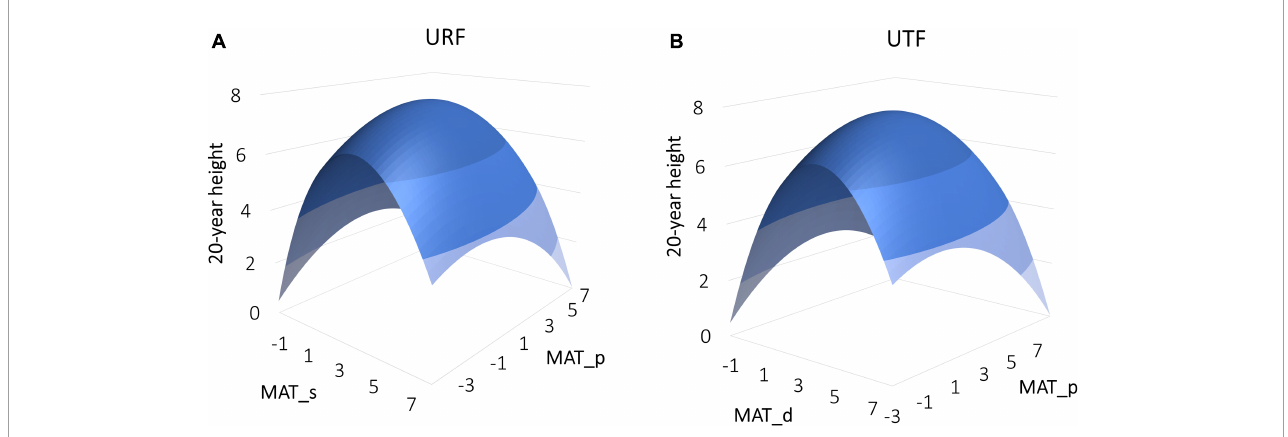
FIGURE1 Response surfaces of 20-year tree height of lodgepole pine to climate predicted by a simple regression universal response function (URF) (A) and universal transfer function (UTF) (B) . The URF is fitted with mean annual temperature for test site (MAT_s) and provenance (MAT_p), while the UTF is fitted with climate transfer distance (MAT_d = MAT_s – MAT_p) and provenance (MAT_p).